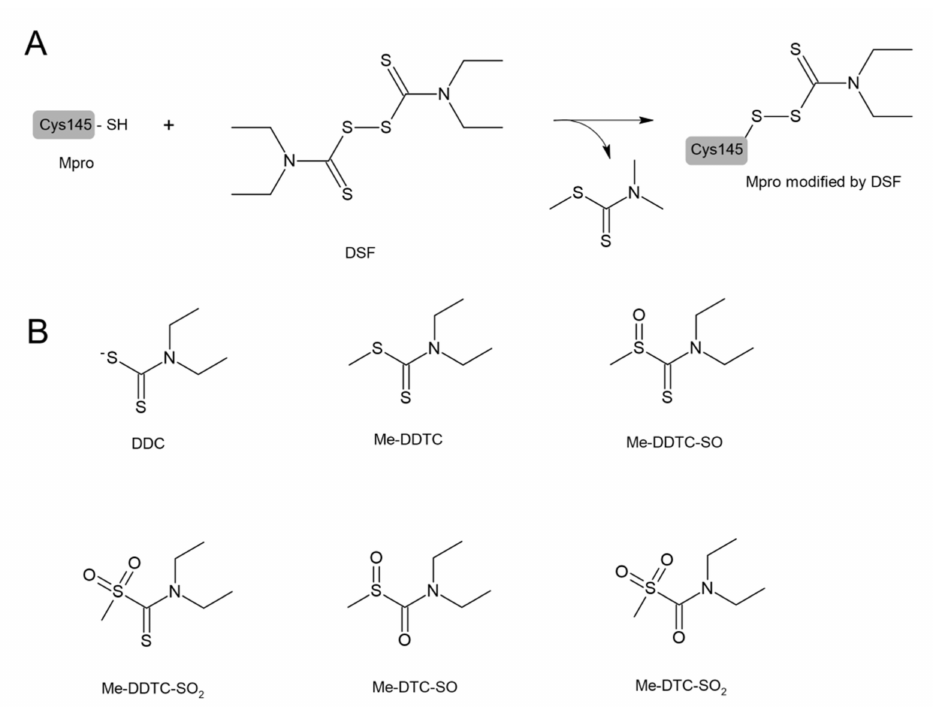
Figure 6. ( A ) A possible mechanism of modification of the catalytic Cys145 of SARS-CoV-2 Mpro by disulfiram (DSF) leading to the inhibition of Mpro activity. ( B ) The products of DSF metabolism that have the ability to inhibit SARS-CoV-2 include N,N-diethyldithiocarbamate (DDC); S-methyl N,N-diethyldithiocarbamoyl sulfide (MeDDTC); S-methyl-N,N-diethyldithiocarbamoyl sulfoxide (MeDDTC-SO); S-methyl-N,N-diethyldithiocarbamoyl sulfone (MeDDTC-SO2); S-methyl- N,N-diethylthiocarbamoyl sulfoxide (MeDTC-SO); and S-methyl-N,N-diethylthiocarbamoyl sulfone (MeDTC-SO2). The mechanism of the Mpro inhibition by these compounds is similar to that presented for DSF (for details see